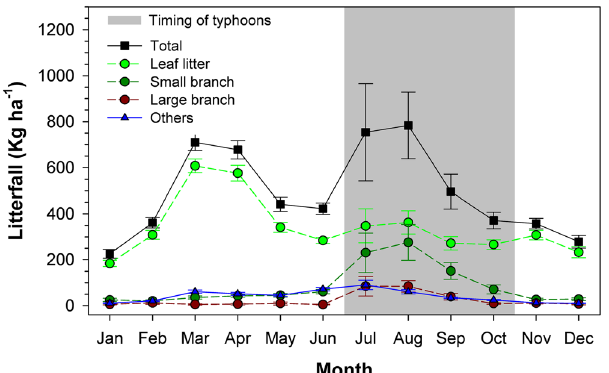
Figure 2. The monthly mean litterfall between 1992 and 2012. The error bars indicate one standard deviation. Gray area indicates typhoon occurring